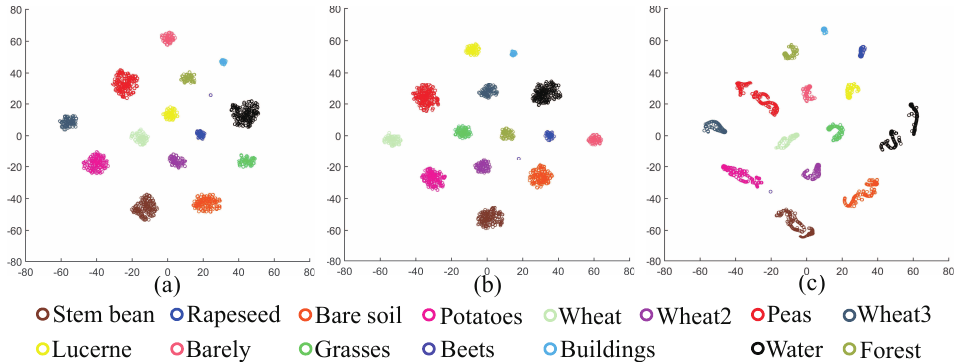
Figure 20. Visualization of data distribution with different methods. ( a ) HCapsNet. ( b ) CNN- CapsNet. ( c ) 2D-CNN.